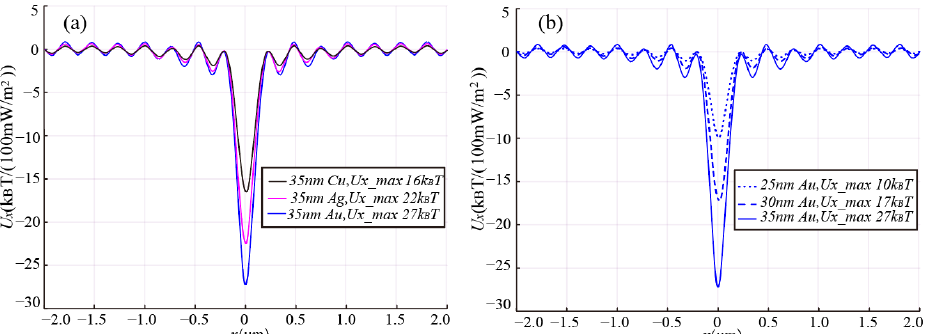
Figure 6. Distribution of trapped potential energy of spheres with different materials ( a ) and spheres with different radii ( b ) along the axis of the annular slit excited by radially polarized